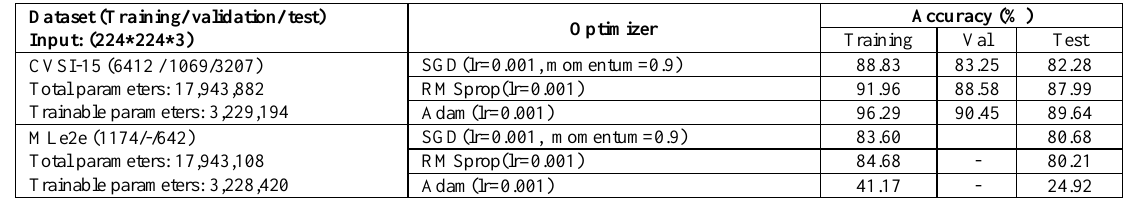
Table 1. VGG-16 fine-tuning on CVSI-15 and MLe2e dataset.